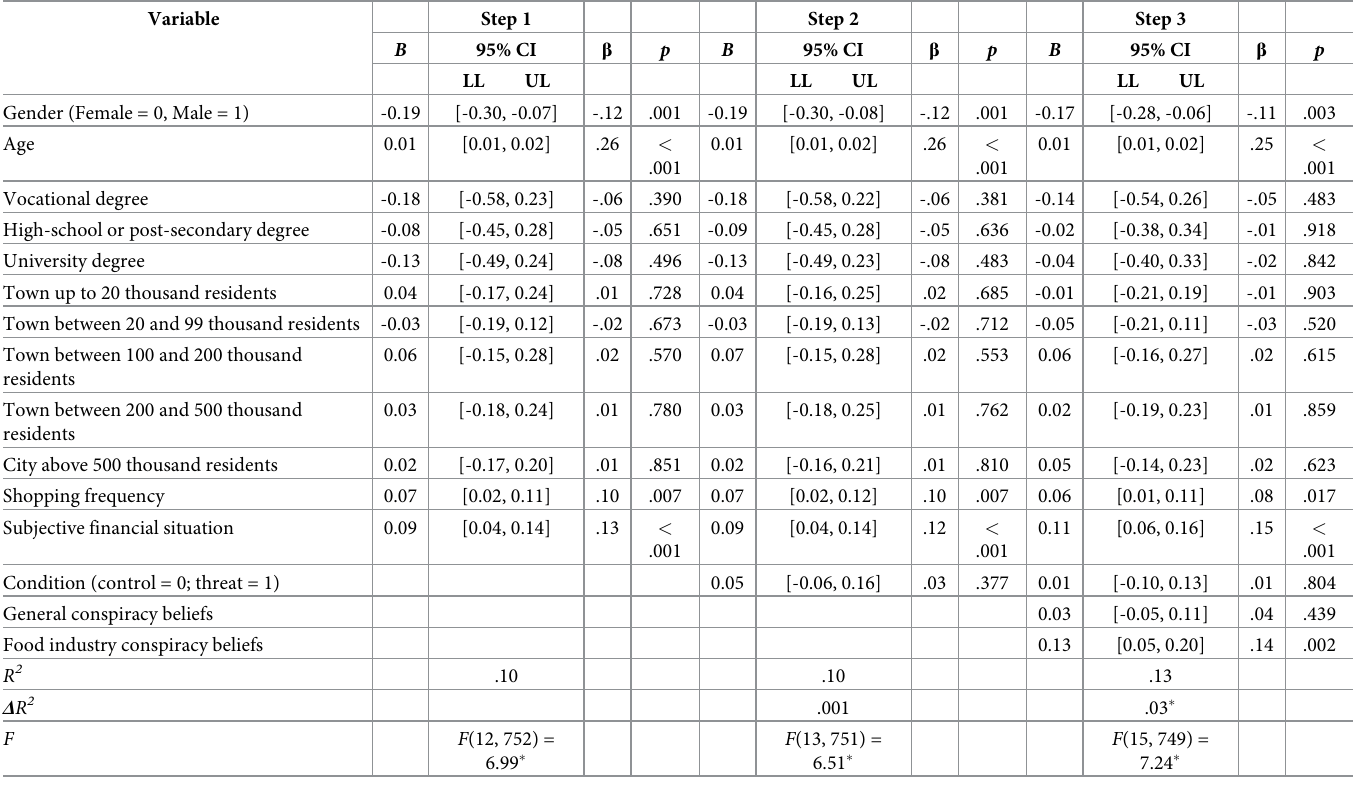
Table 6. Predictors of conscious food choices (Study